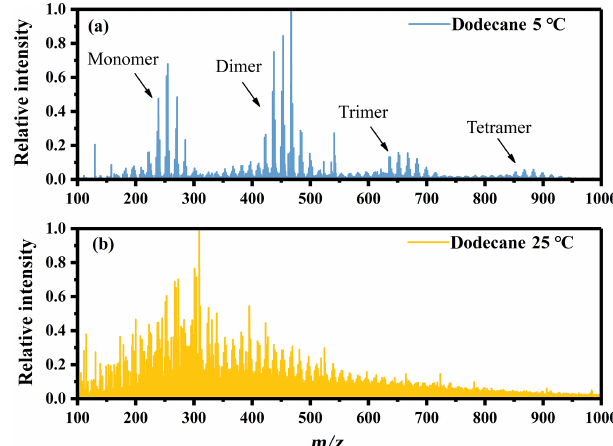
Figure 3. Mass spectra of n -dodecane SOA obtained by ESI-ToF- MS in positive ion mode. (a) Low-temperature conditions and (b) room temperature